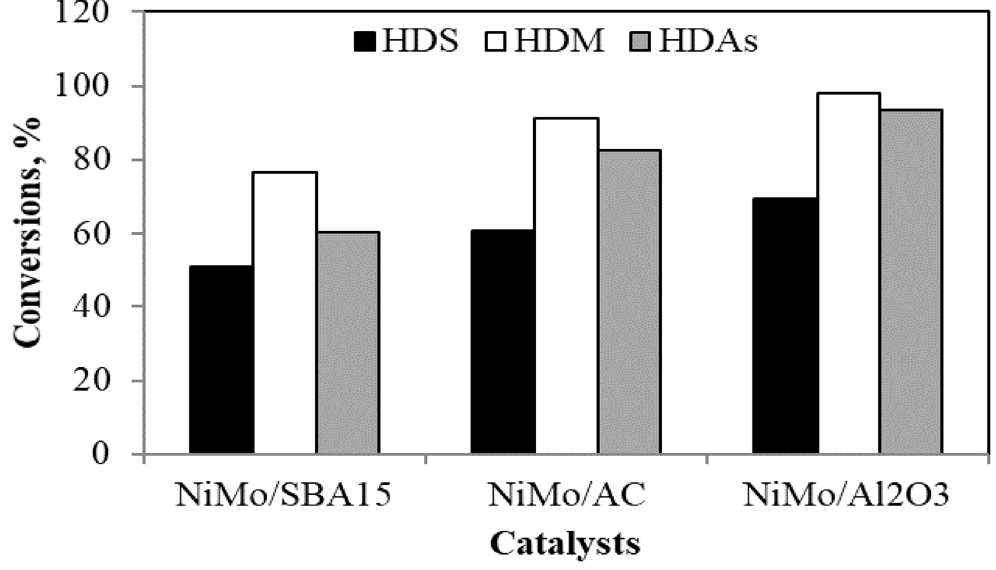
Figure 5. Hydrotreating conversions by the NiMo catalysts. (HDS = Hydrodesulfurization; HDM = Hydrodemetallization; and HDAs = Asphaltene conversion).